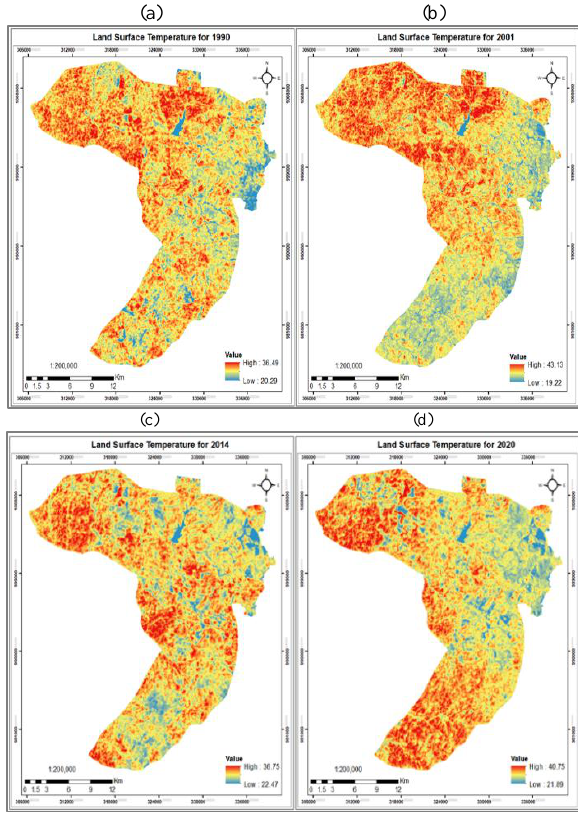
Figure 4: Land surface temperature distribution in Abuja City (a) 1990 (b) 2001 (c) 2014 (d) 2020 The minimum, maximum, standard Deviation and mean LST has shown a gradual increase between 1990 and 2020 (Table 5). The minimum LST ranged from 19°C to 23°C, while maximum LST ranged from 36°C to 43°C and mean LST ranged between 30°C to 34°C. The mean LST increased by 2.56 °C from 1990 to 2020. The result concur with (Mwangi et al., 2021; Oke, 1973).